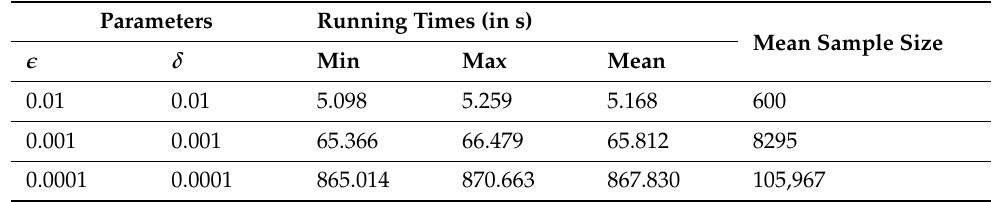
Table 11. TATA-box: On-the-fly verification of